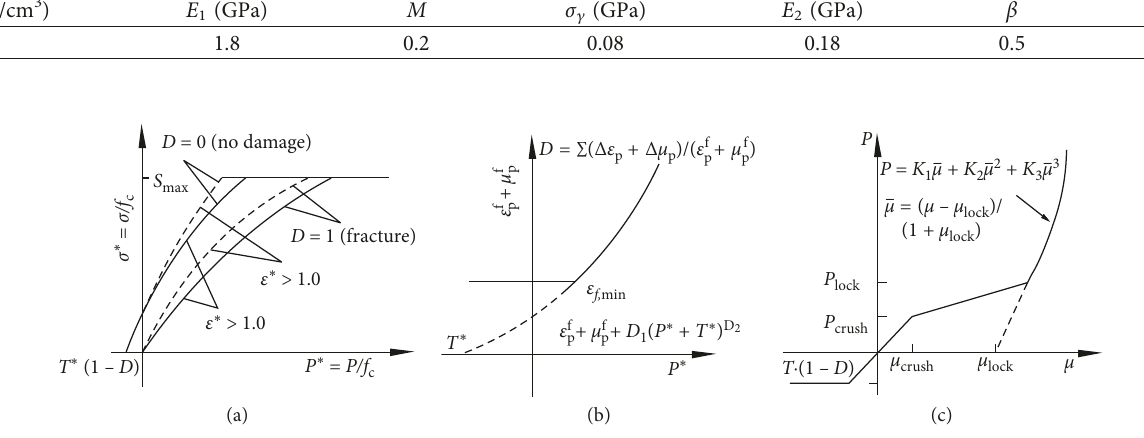
Figure 4: HJC concrete model. (a) Yield surface equation. (b) Damage evolution equation. (c) State equation.